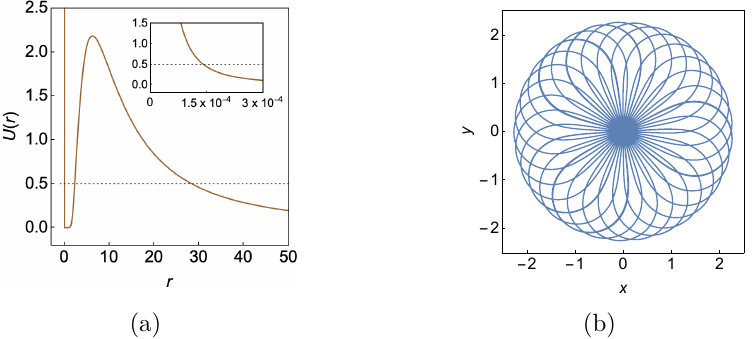
Figure 10 . An example of bound state for the sixth derivative scalar theory. Here we set g = 100 , µ = 1 , ω = 2 , a = 2 , b = 0 . 1 and evolved the system until a final time t f = 200 : (a) effective potential; (b) the trajectory of the system in the xy